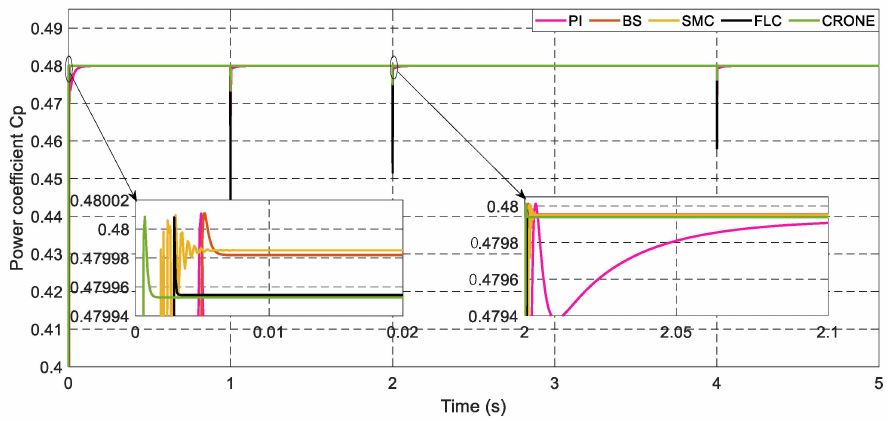
Figure 12. Power coefficient for PI, BS, SMC, FLC, and CRONE controllers.